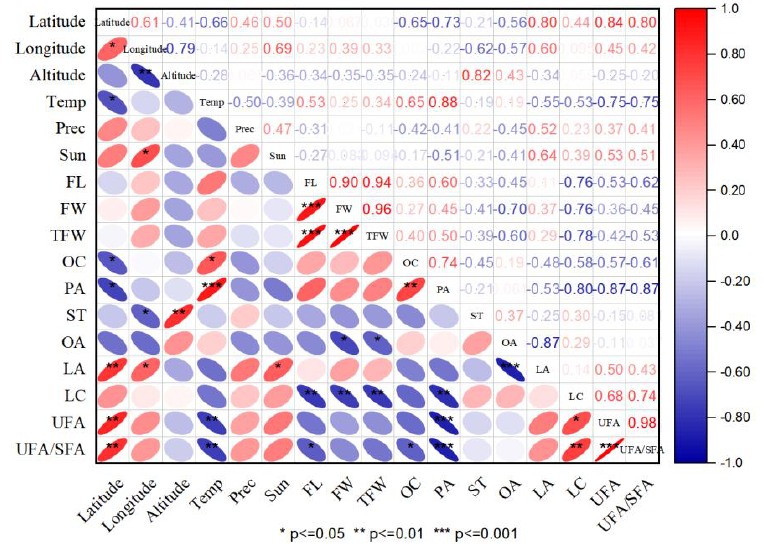
Figure 2. Correlation coefficients among indexes of S. wilsoniana fruits. Abbreviations: Temp., average monthly temperature; Sun. Dur., average annual sunshine duration; Prec., average annual precipitation; FL, fruit length; FW, fruit width; TFW, thousand fruit weight; OC, oil content; PA, palmitic acid; SA, stearic acid; OA, oleic acid; LA, linoleic acid; LC, linolenic acid; UFA, unsaturated fatty acid; SFA, saturated fatty acid.